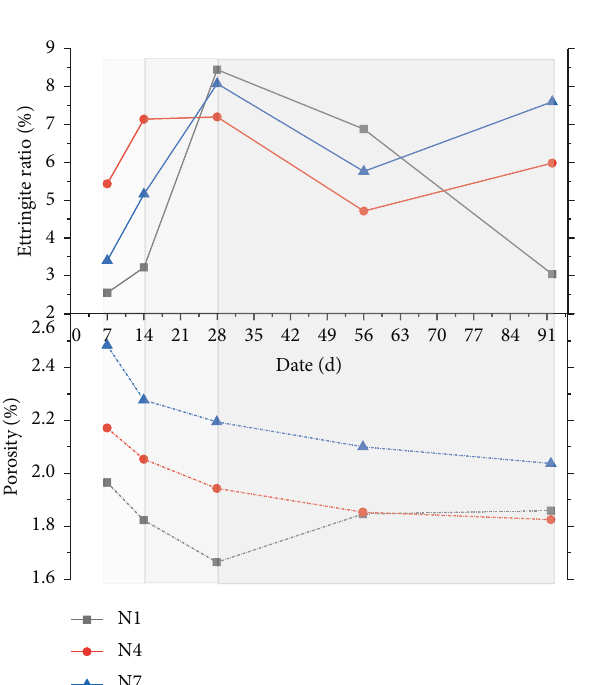
Figure 11: Variation chart of ettringite